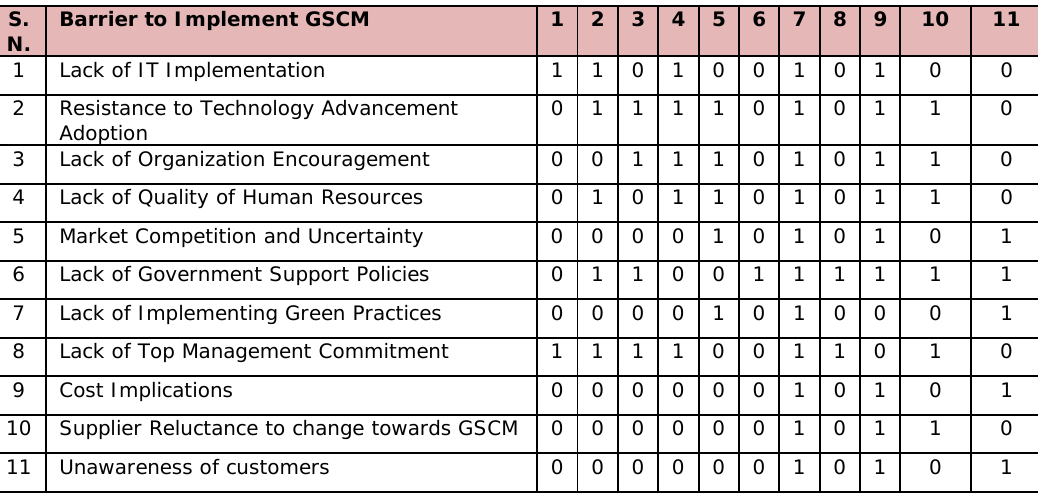
Table 4. “Initial Reachability Matrix for Barriers to Implement GSCM in Indian Automobile S. N.